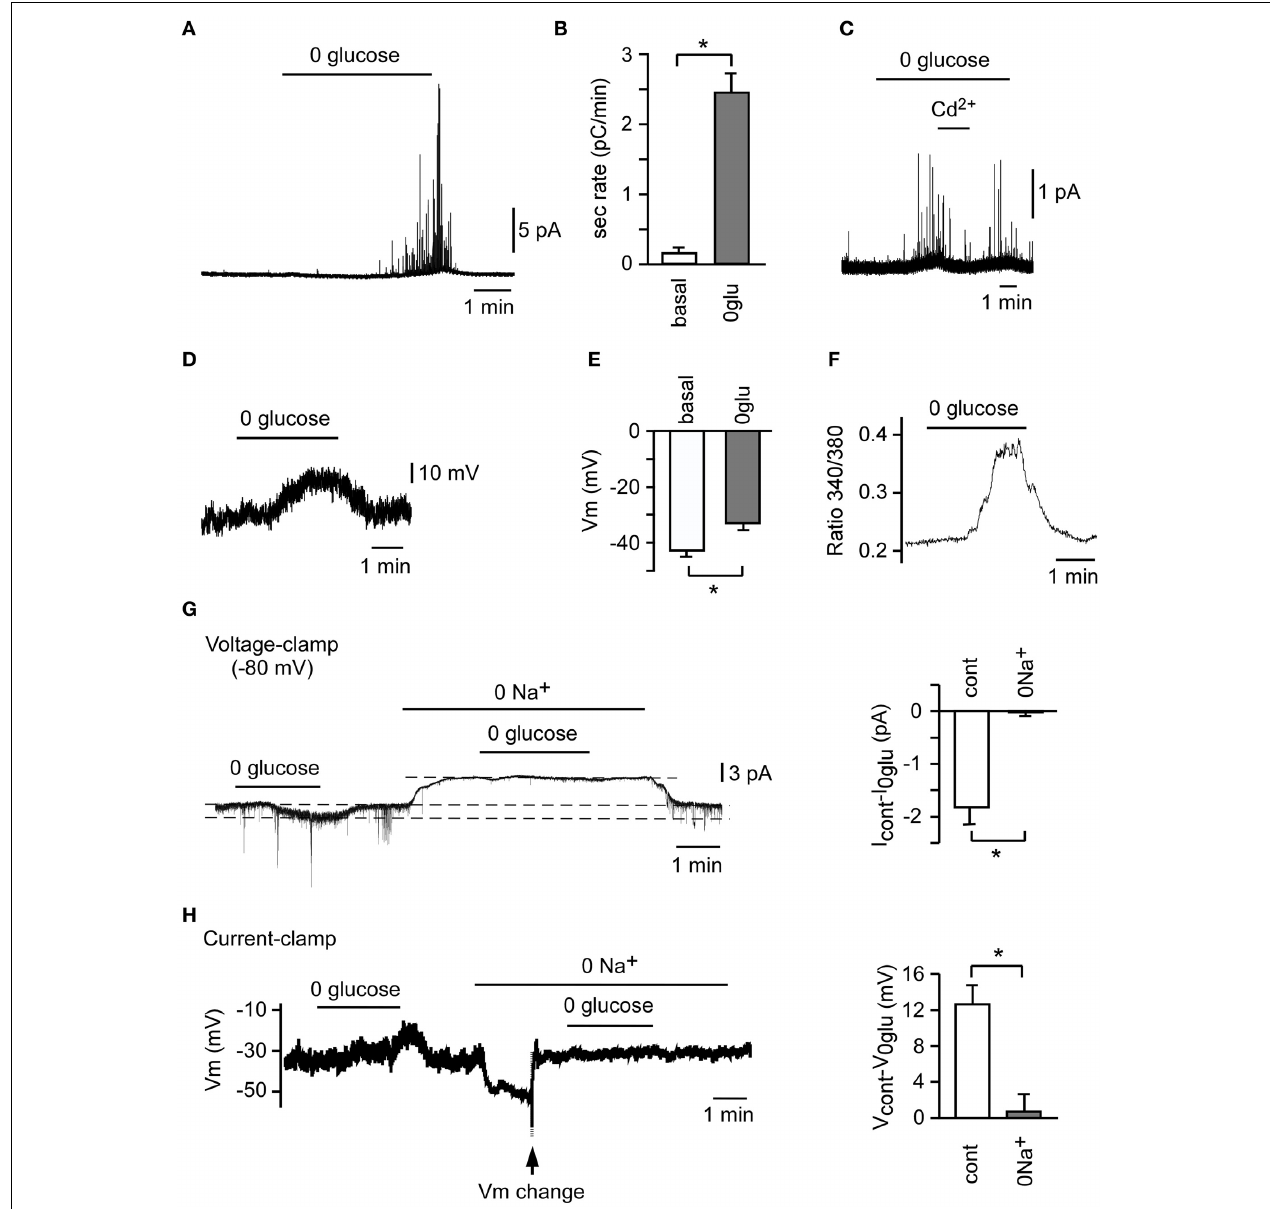
glucose-induced increase in current (Icontrol-I0glu) by replacement of extracellular Na + with N-methyl-D-glucamine (0 Na + ) in voltage-clamped glomus cells ( n = 3). (H) Inhibition of 0 glucose-induced depolarization (Vcontrol-V0glu) by replacement of extracellular Na + with N-methyl-D-glucamine (0 Na + ) in current-clamped glomus cells ( n = 3). To compensate for the hyperpolarization induced by 0 Na + , Vm was changed manually to the previous resting value (arrow) ∗ p < 0 . 05 (Modified from Garcia-Fernandez et al.,